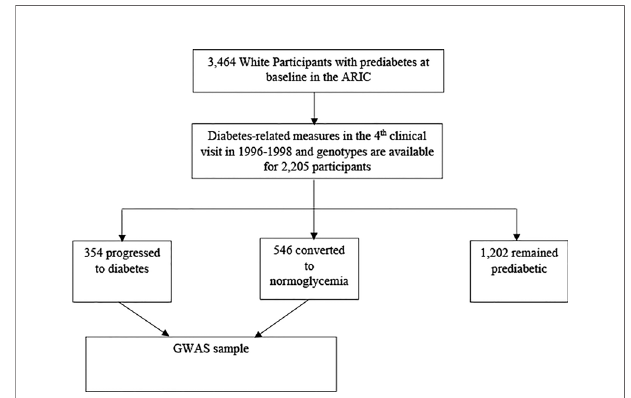
FIGURE 1 | Flow Chart of Participant Selection in ARIC